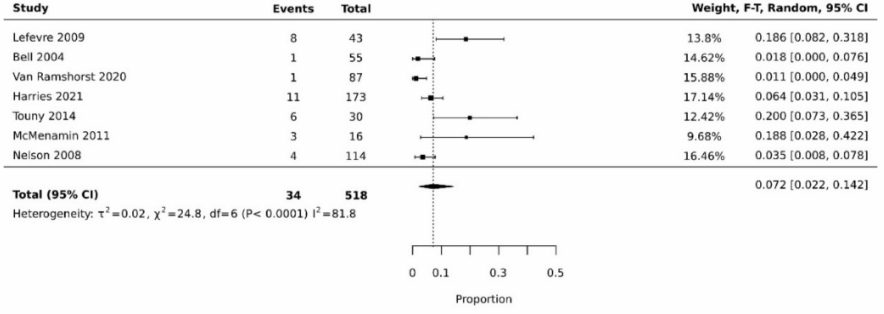
Figure 10. Forest plot for donor site herniation for VRAM